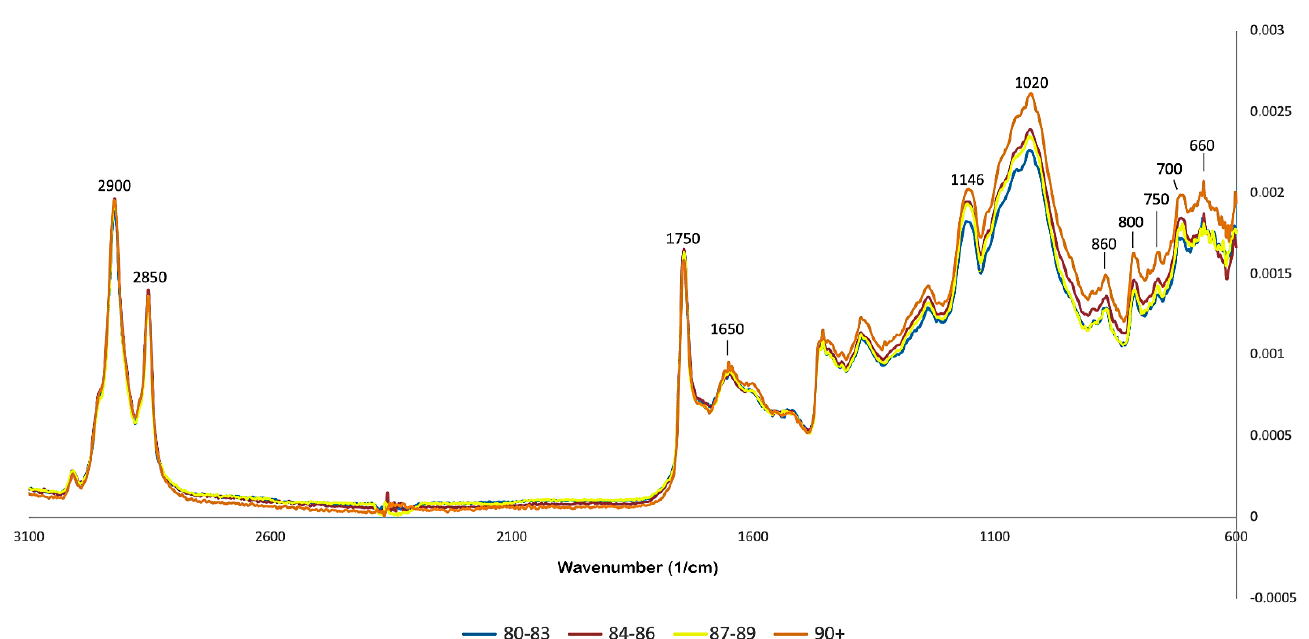
Figure 1. Average FTIR spectra obtained for roasted coffee (colors are related to sensory quality scores).